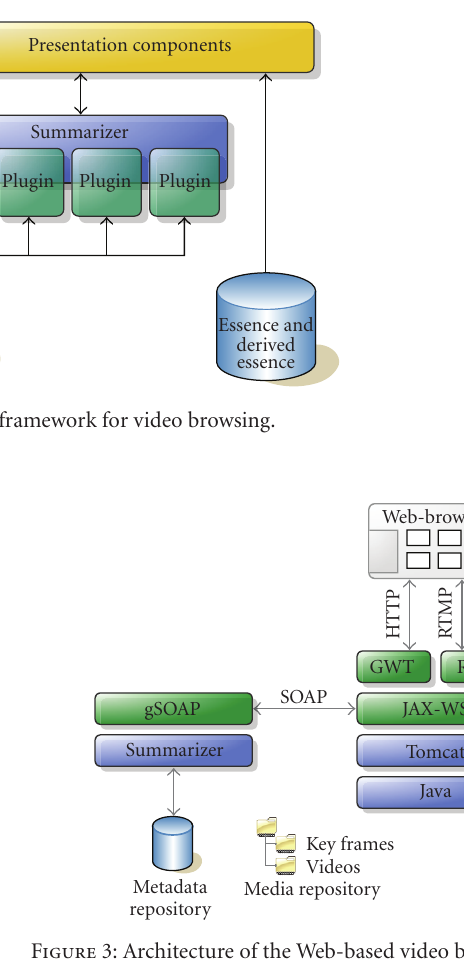
Figure 3: Architecture of the Web-based video browsing